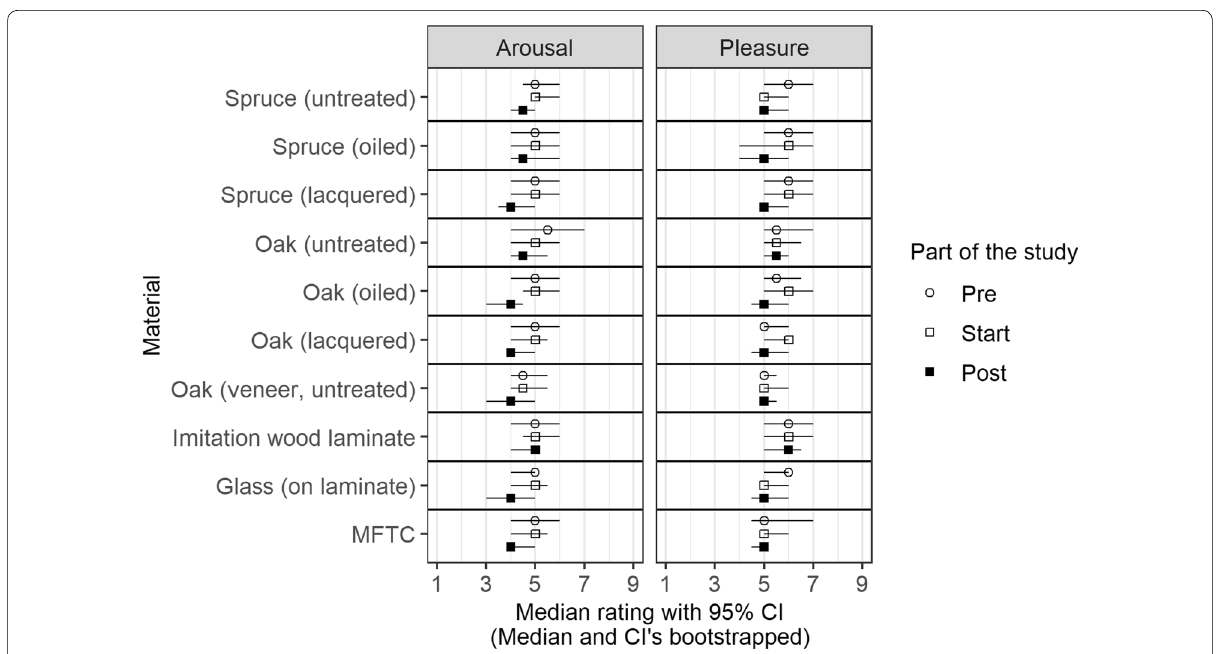
Fig. 5 Arousal and pleasure scores grouped by materials and measurement time